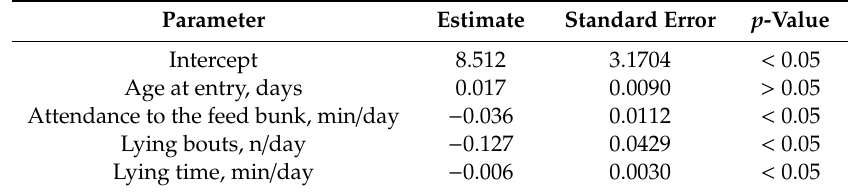
Table 3. The analysis of maximum likelihood estimates for the parameters of the prediction model for d −